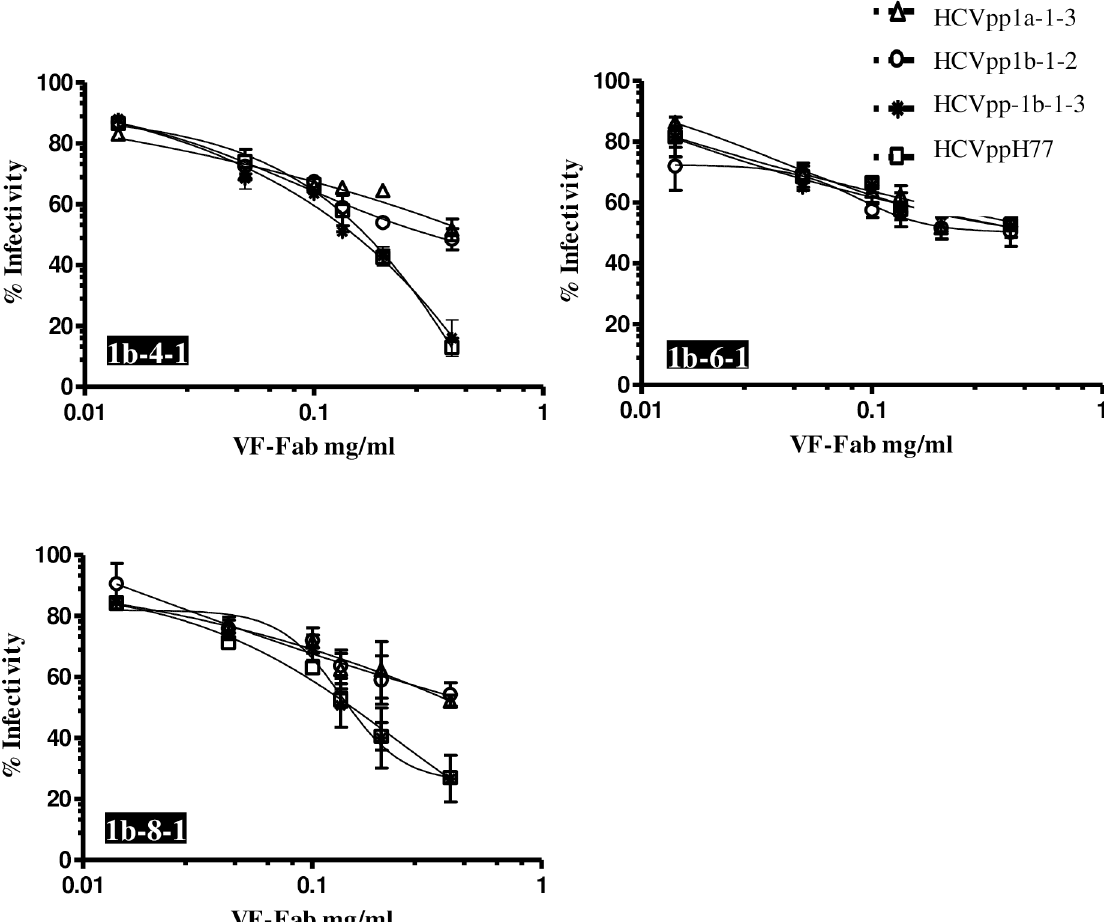
Fig 4. VF-Fab from sera without detectable AAV shows neutralisation activity. VF-Fab1b-4-1, VF-Fab1b-6-1, VF-Fab1b-8- 1 were purifiedfrom three unrelatedpatients infected with HCV genotype1b that were negative for presenceof AAV. HCVpp incorporating E1E2 derived from genotype1a (HCVpp1b-1-3, HCVppH77)and 1b (HCVpp1b-1-2, HCVpp1b-1-3) were pre- incubatedwith different concentrations (0.006 to 0.4 mg/ml) of purifiedVF-Fabs prior to infectionof Huh7 cells. A no envelope control was used to normalisethe data. The neutralising activity of the VF-Fab is expressedas percentage of inhibitionof the infectioustitres. Each experiment was repeatedthree times. IC 50 for each VF-Fab is detailed in Table 3. Error bars indicate standard